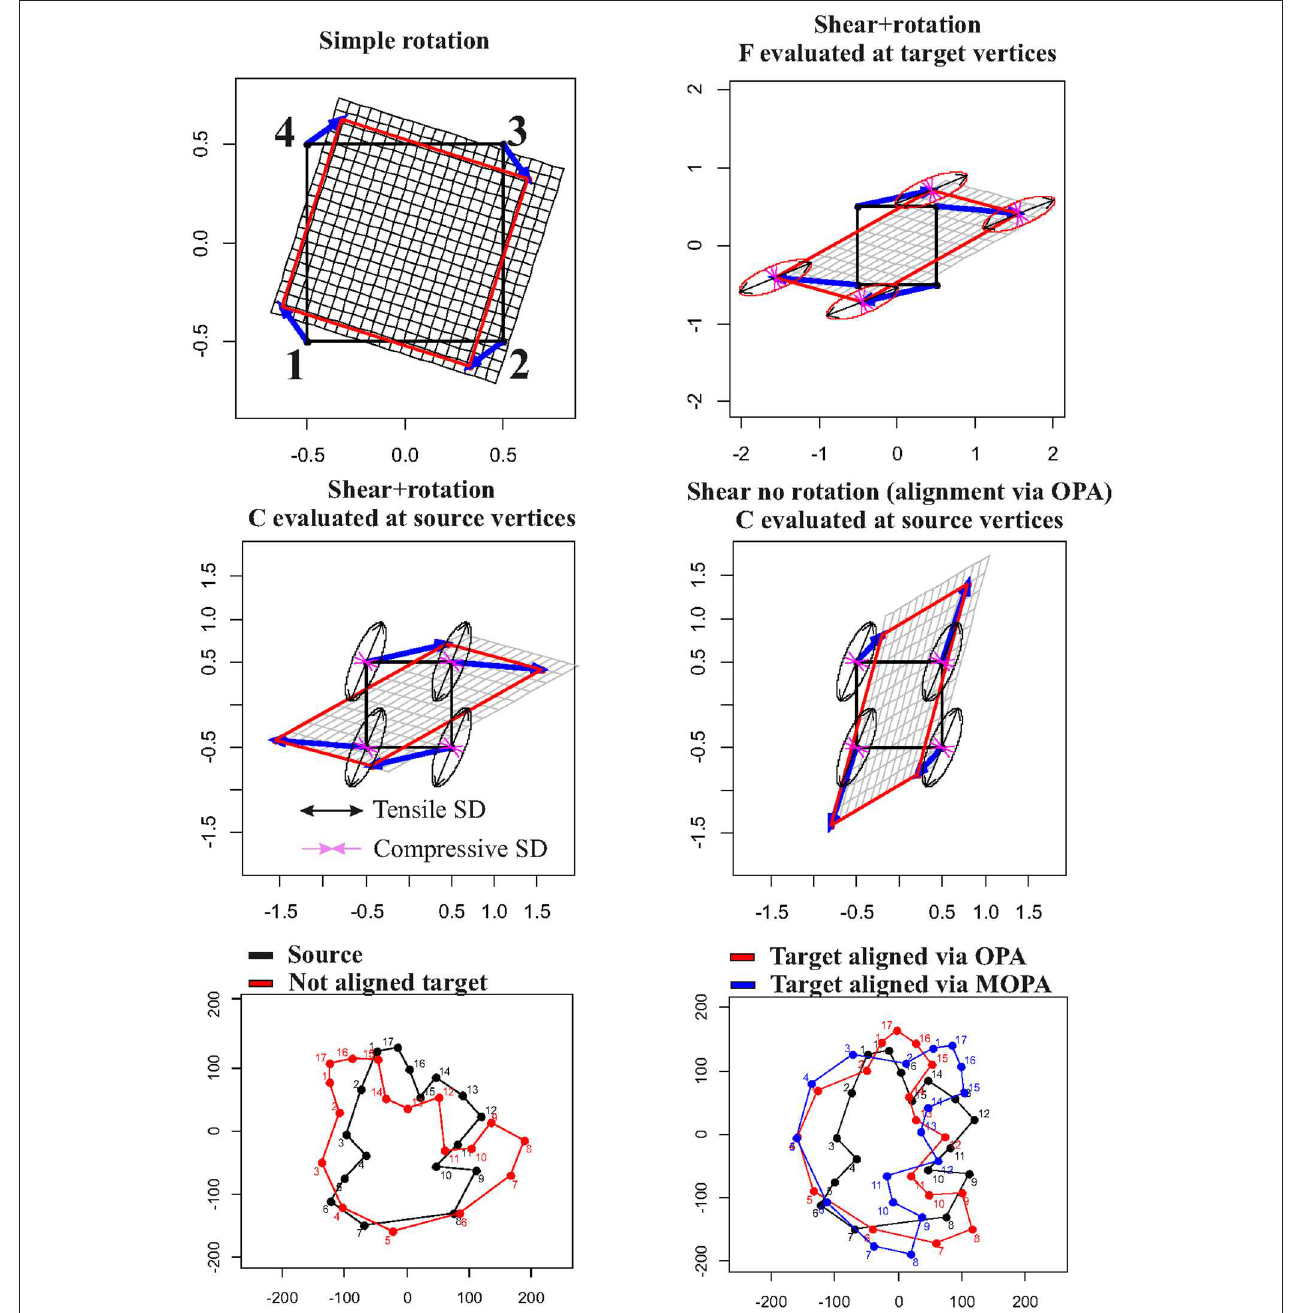
FIGURE 2 | Relationship between displacement vectors (in blue) and local deformations as depicted using √ C (on the source) or F (on the target). First row, left panel : a simple rotation that produces displacements without deformation; first row, right panel : a shear rotation with deformation ellipses evaluated at target + vertices; second row, left panel : the same shear rotation with deformation ellipses evaluated at source vertices; second row, left panel : the same shear without + global rotation (filtered out via OPA) with deformation ellipses evaluated at source vertices; third row, left panel : a generic source (in black) and a non-aligned generic target (in red); third row, right panel : plot with source and the target aligned using OPA (in red) or MOPA (in blue). Principal strain directions ( ellipse’s axes) are in = black if tensile and in violet if